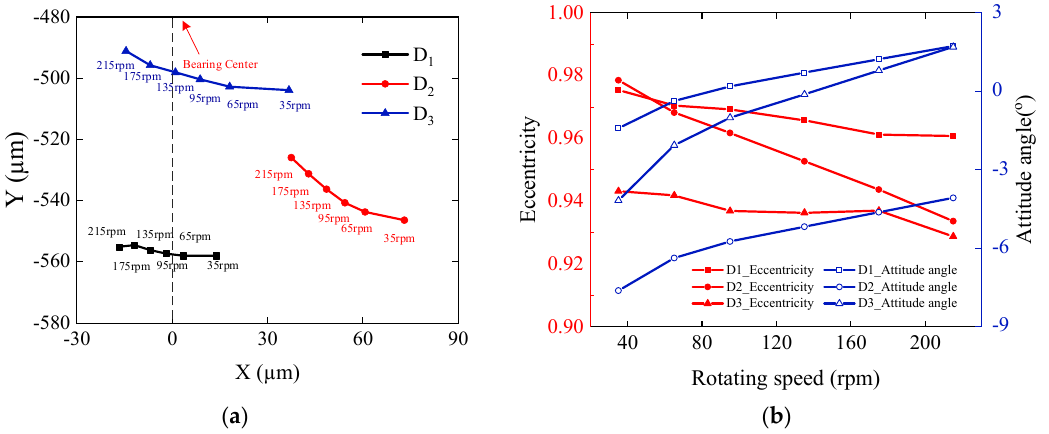
Figure 12. Journal position status at different speeds: ( a ) Axis position and ( b ) Eccentricity and ec ‐ centricity angle.